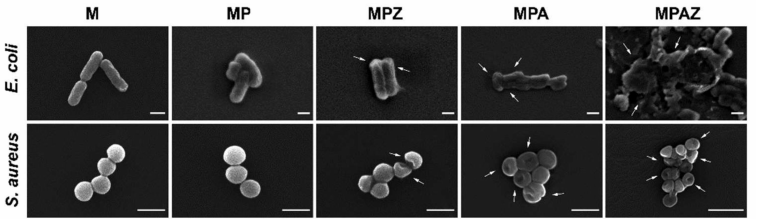
Figure 9. SEM of bacteria in the presence of different films. The arrows indicated the deformation, shrinking, and damage of bacterial cell walls. Scale bar, 1 µ